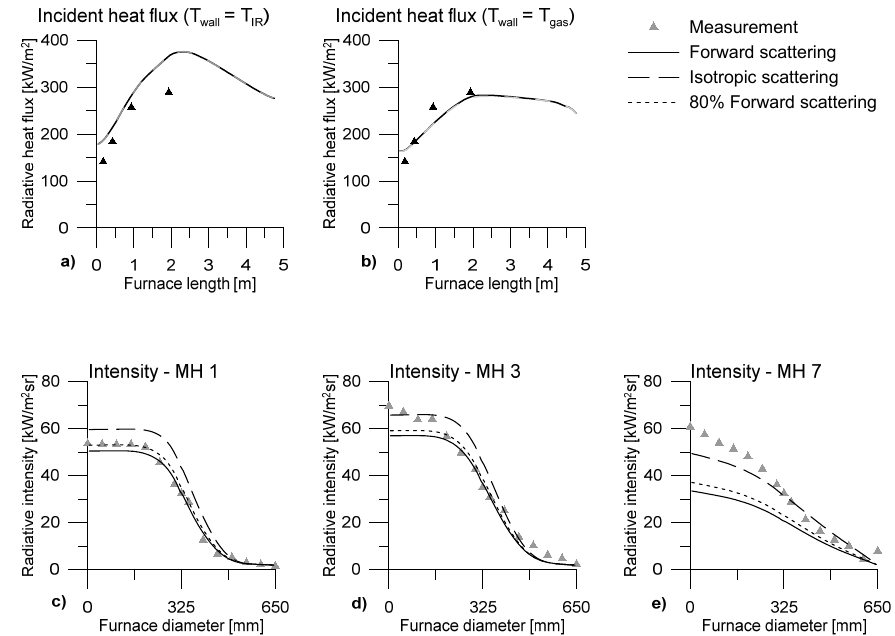
Figure 6. Measured (triangles) and modelled radiation assuming isotropic (dashed), forward (continuous) and 80% forward scattering (dotted). The incident radiative heat flux at the inner wall for measurement ports MH 0, 1, 3 and 7 along the furnace axis with the wall temperature set from ( a ) the IR camera and ( b ) the gas temperature closest to the wall. Measured and modelled radiative intensities along the furnace diameter at ports ( c ) MH 1, ( d ) MH 3 and ( e ) MH 7.